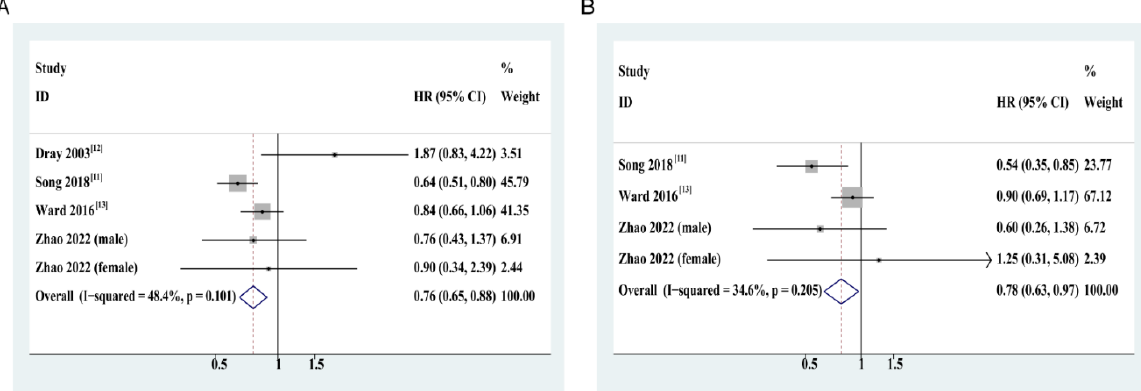
Figure 2. Summary forest plots of hazard ratios (HRs) with 95% confidence intervals (CIs) of mortality for highest dietary fiber intake relative to lowest. ( A ) All-cause mortality; ( B ) CRC-specific mortality. Abbreviations: CRC, colorectal cancer; HR, hazard ratio; CI, confidence interval. Squares indicate study-specific HR estimates (the size of the square reflects the study-specific statistical weight, i.e., the inverse of the variance); horizontal lines indicate the 95% CI; diamonds indicate the pooled HRs with their 95% CI. Study-specific HR estimates were pooled using a fixed-effects model.